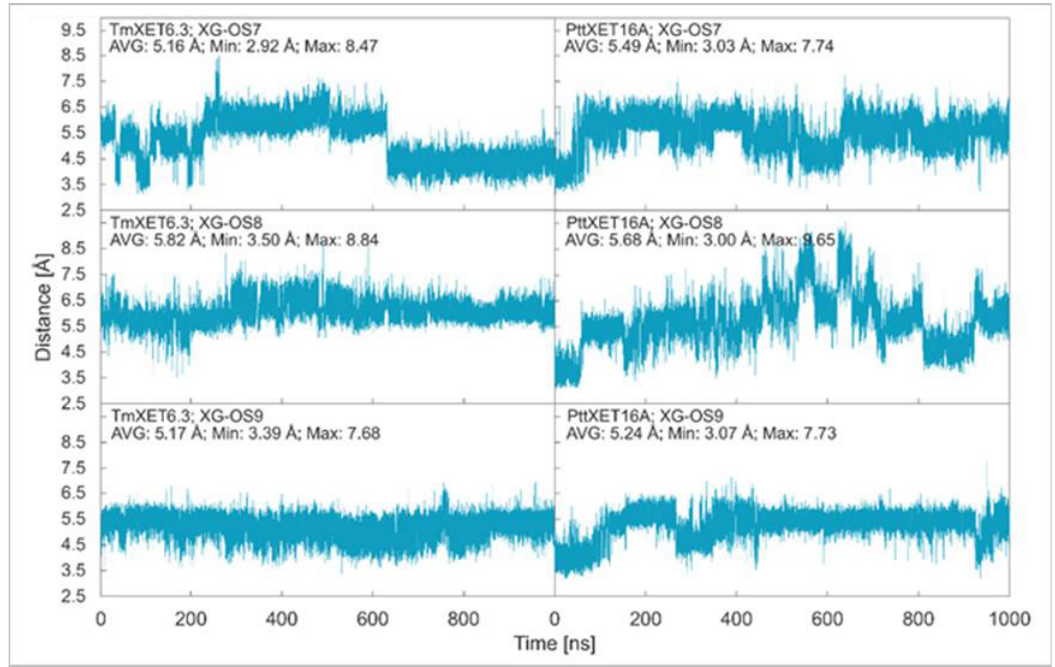
Figure 2. Time dependence of the distance (Å) between the C1 atom of the donors and the O4 atom of acceptors during MD simulations with TmXET6.3 and PttXET16-34A. The C1 and O4 atoms form a glycosidic bond.